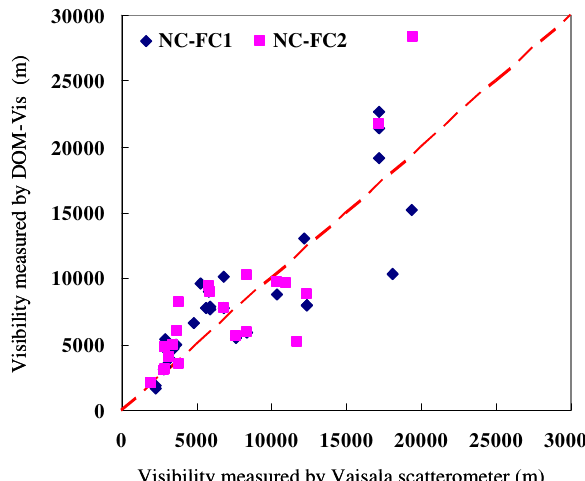
Fig. 4. Comparison of Vaisala scatterometer measurements to Figure 4. Comparison of Vaisala scatterometer measurements to DOM-Vis results from 486 DOM-Vis results from NC and FC1 (blue diamonds), and NC and NC and FC1 (blue diamonds), and NC and FC2 (pink squares) during daytime tests. 487 FC2 (pink squares) during daytime